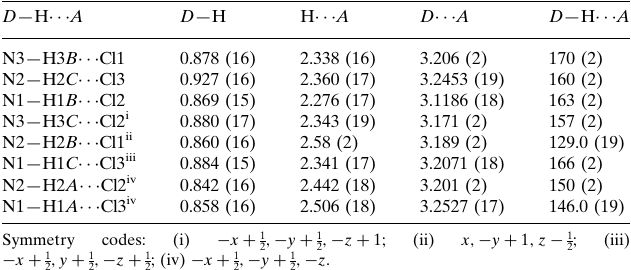
Hydrogen-bond geometry (A˚ , (cid:3)